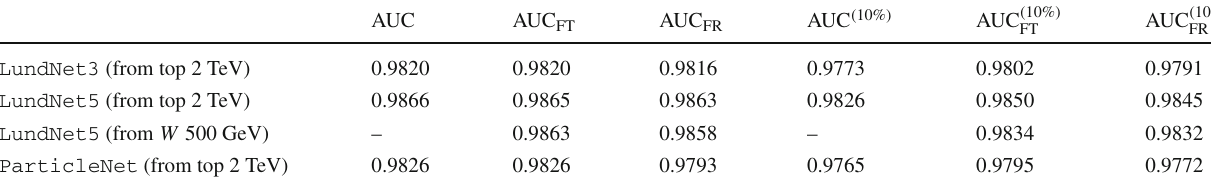
Table 2 Benchmarks for top tagging with p T > 500 GeV. The differ- ent columns show the AUC for the different transfer learning models considered in the text, where FT denotes the fine-tuning option, FR